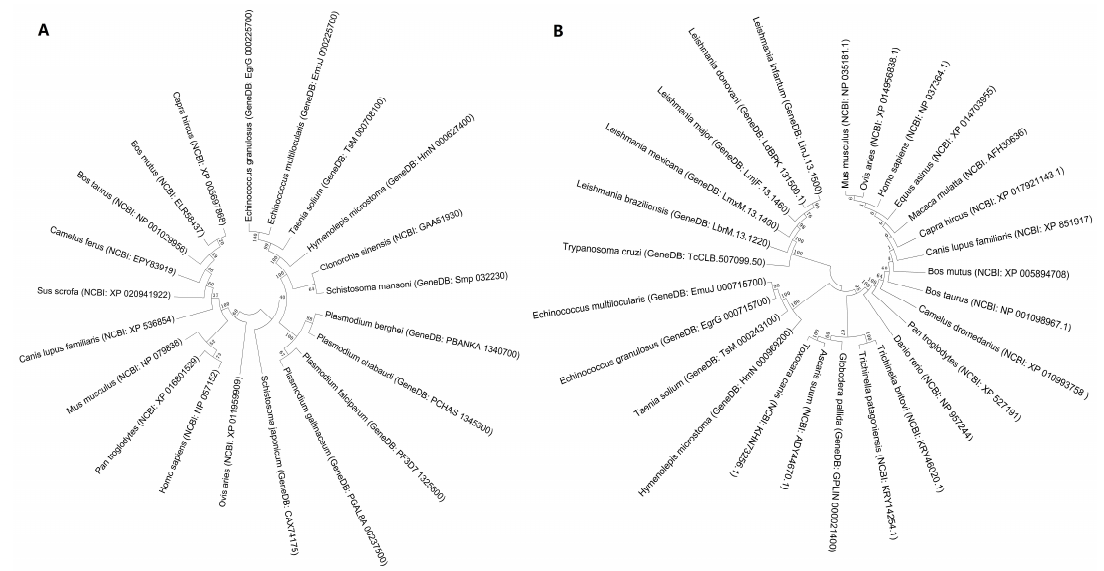
Figure 2. Phylogenetic (neighbour-joining) trees of Eg-Fis1 and Eg-PDCD6. ( A ) Phylogenetic analysis of Eg-Fis1 and its homologs; ( B ) Phylogenetic analysis of Eg-PDCD6 with and its homologs.